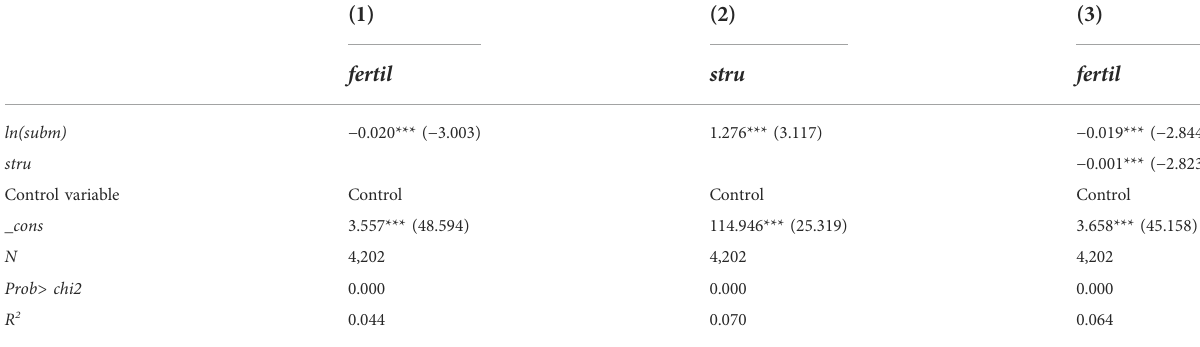
TABLE 5 Mediating effect of planting structure.